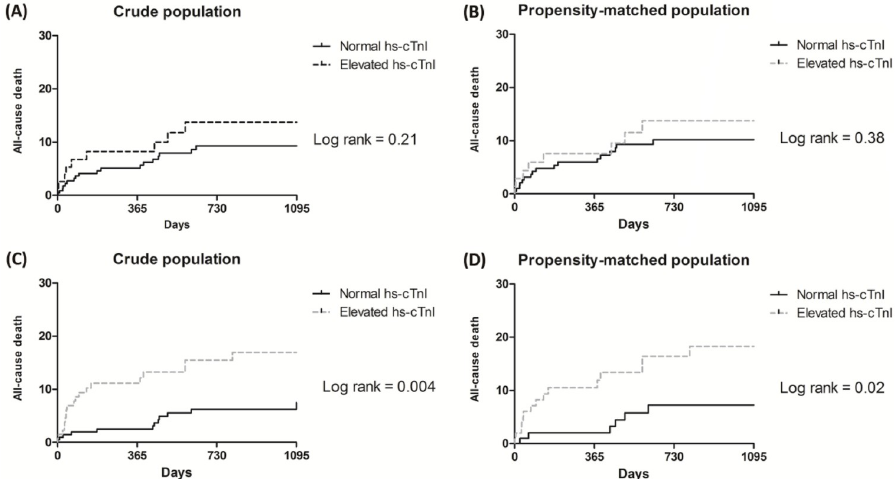
Fig 3. Kaplan-Meier curves for the groups with elevated hs-cTnI and normal hs-cTnI in pre- and postoperative analyses. Curves for (A) the entire preoperative population, (B) the propensity-matched preoperative population, (C) the entire postoperative population, and (D) the propensity-matched postoperative population.